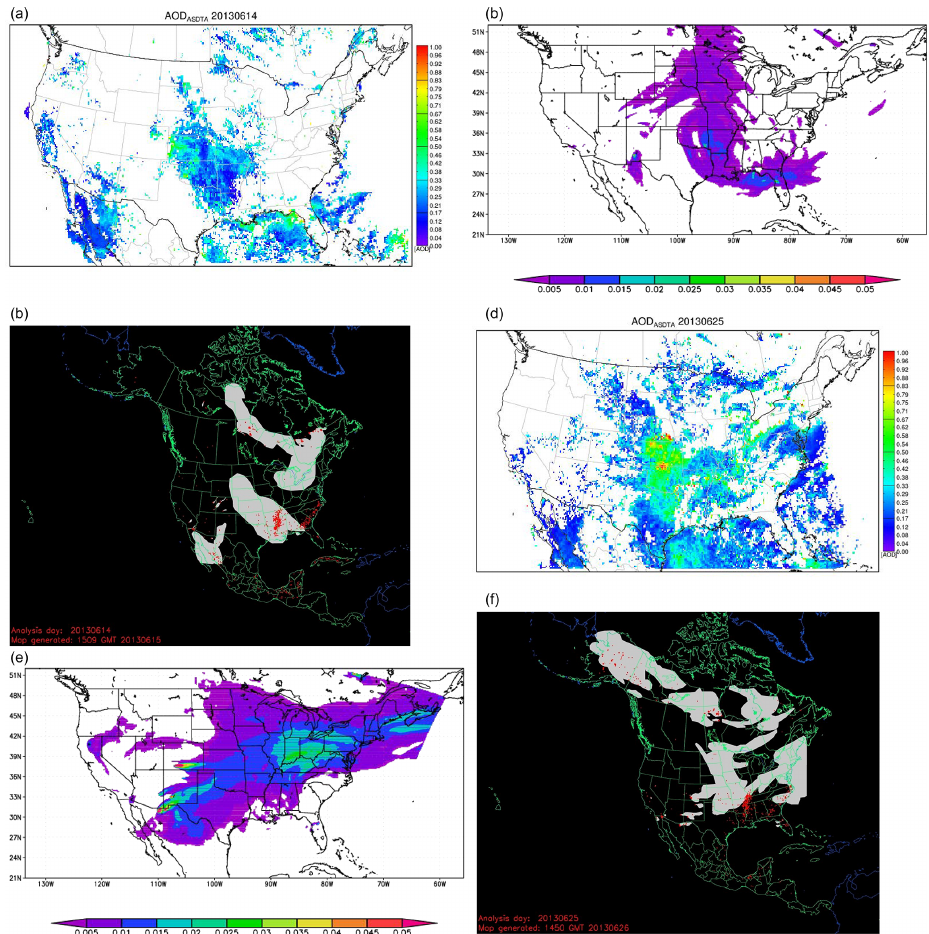
Figure 7. GOES-detected AOD influenced by fires using the ASDTA diagnostic method (summed over 10:00 to 14:00 local time). Color- shaded region represents the fire-smoke-influenced areas, and the color denotes the magnitude of the retrieved AOD on (a) 14 June 2013 and (d) 25 June 2013; simulated (cid:49) AOD (with-fire − without-fire) calculated by CMAQ on (b) 14 June 2013 and (e) 25 June 2013; and HMS-observed fire hotspots (red) and plume shapes (white) on (c) 14 June 2013 and (f) 25 June 2013.